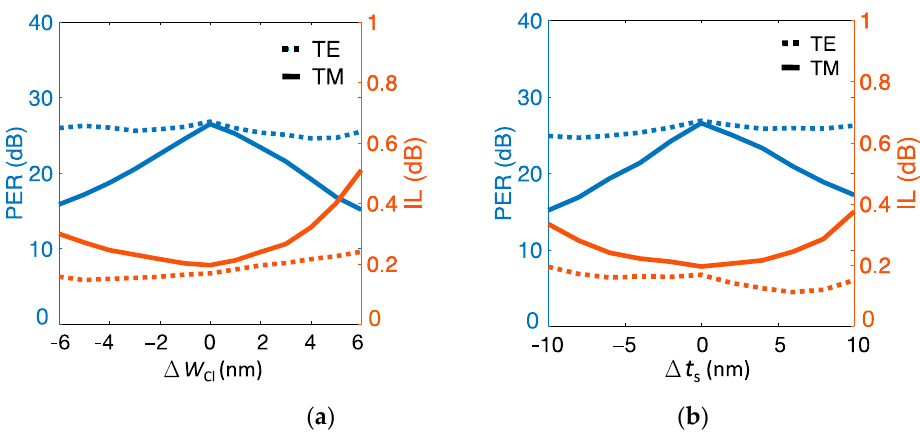
Figure 9. (left axis) PER and (right axis) IL as functions of variations in the ( a ) Si strip width Δ W Cl and ( b ) slot thickness Δ t s of the present structure.